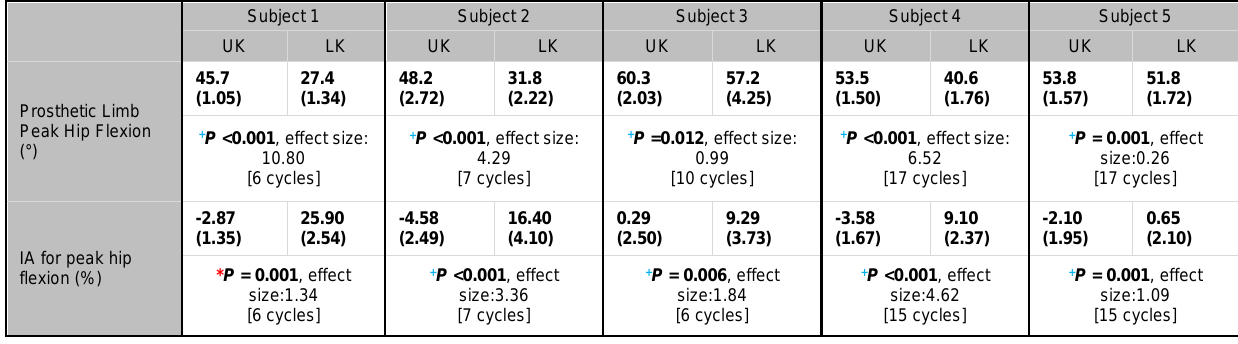
Statistical analyses were conducted using SPSS (v 24.0, IBM Inc., Armonk, NY). The Shapiro-Wilk test (p=0.05) was used to assess data normality for all variables. The UK condition was anticipated to reduce hip kinematic pathologies during swing. Swing phase peak prosthetic limb hip flexion, abduction, and hip frontal and sagittal plane interlimb asymmetry were tested with two-tailed paired t- tests (p=0.05, if normally distributed data) or the Wilcoxon signed-rank test (p=0.05, if non-normally distributed data). All kinematic variables were assessed on a single-subject basis in a separate test for each knee condition, using all retained stride cycles. Thus, there were 6-17 data points per statistical test. The corresponding effect size was calculated using Cohen’s d (normally distributed data) and Equation 2 (non-normally distributed data): Equation 2: r=Z/√N where r represents effect size, Z represents the test statistic, and N represents the number of samples.